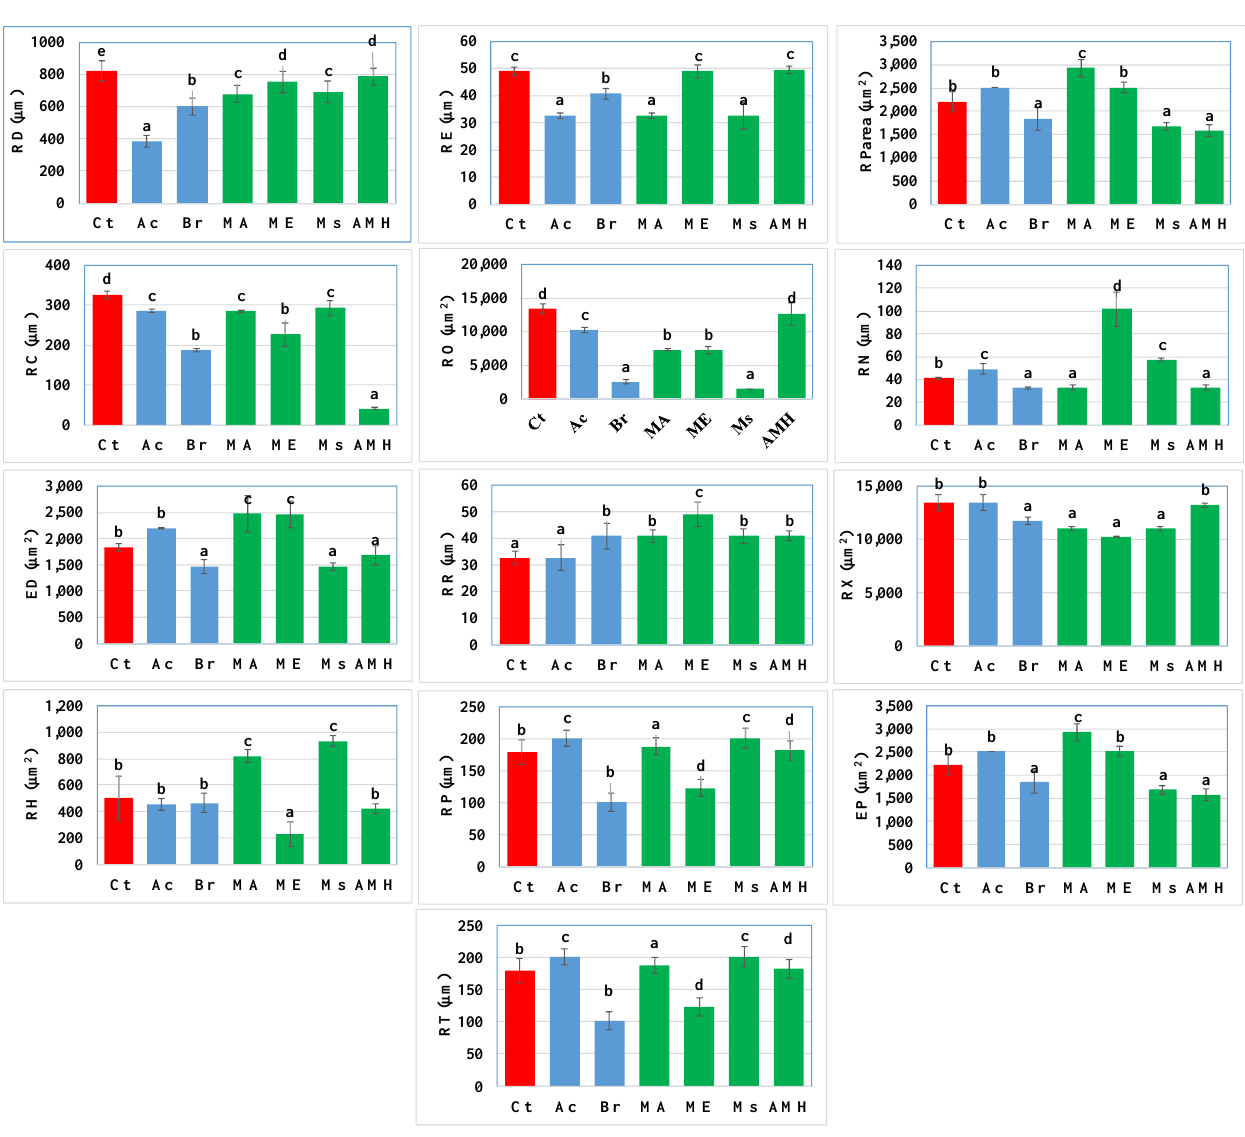
Figure 2. Root anatomical characteristics of Dactyloctenium aegyptium treated with pre- and post-emergence herbicides. Means sharing same lowercase letters on bars are statistically non−significant at p ≤ 0.05%). Red bar indicates control group, blue bars show pre-emergence and green bars are used for post-emergence herbicides. For abbreviations please see list at the end of manuscript. (Figure 2) Metolachlor-Atrazine, and Methyl ester decreased this attribute by 45%,